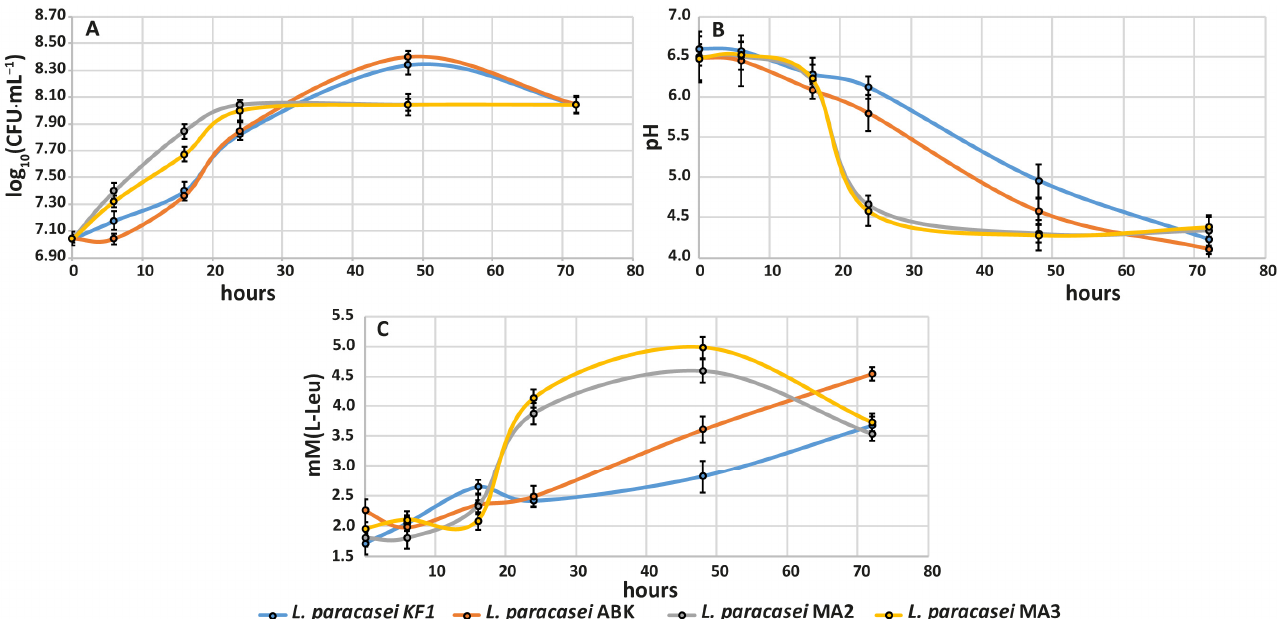
Figure 5. Fermentation characteristics of the kefir-derived (KF1 and ABK) and mahewu-derived (MA2 and MA3) strains of L. paracasei during milk fermentation: ( A ) the dynamics of change in the viable cell count; ( B ) the dynamics of change in the pH value; ( C ) the dynamics of change in the proteolytic activity. The error bars represent the standard deviations from the mean.